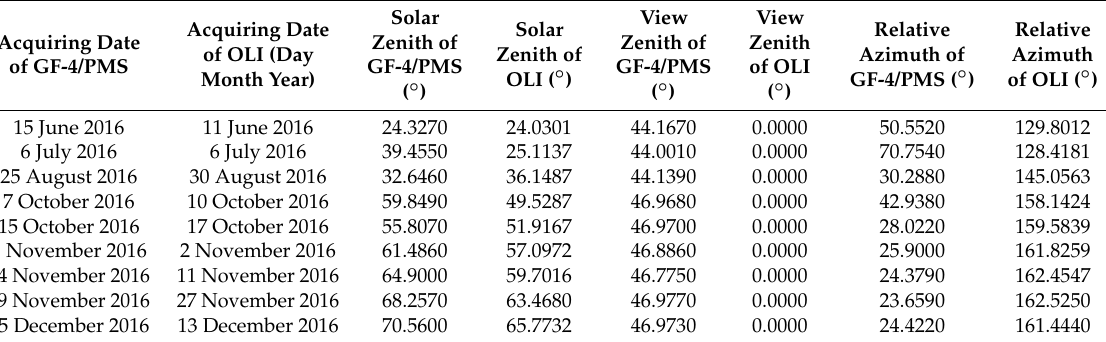
Table 10. Information of the chosen image pairs of GF-4/PMS and